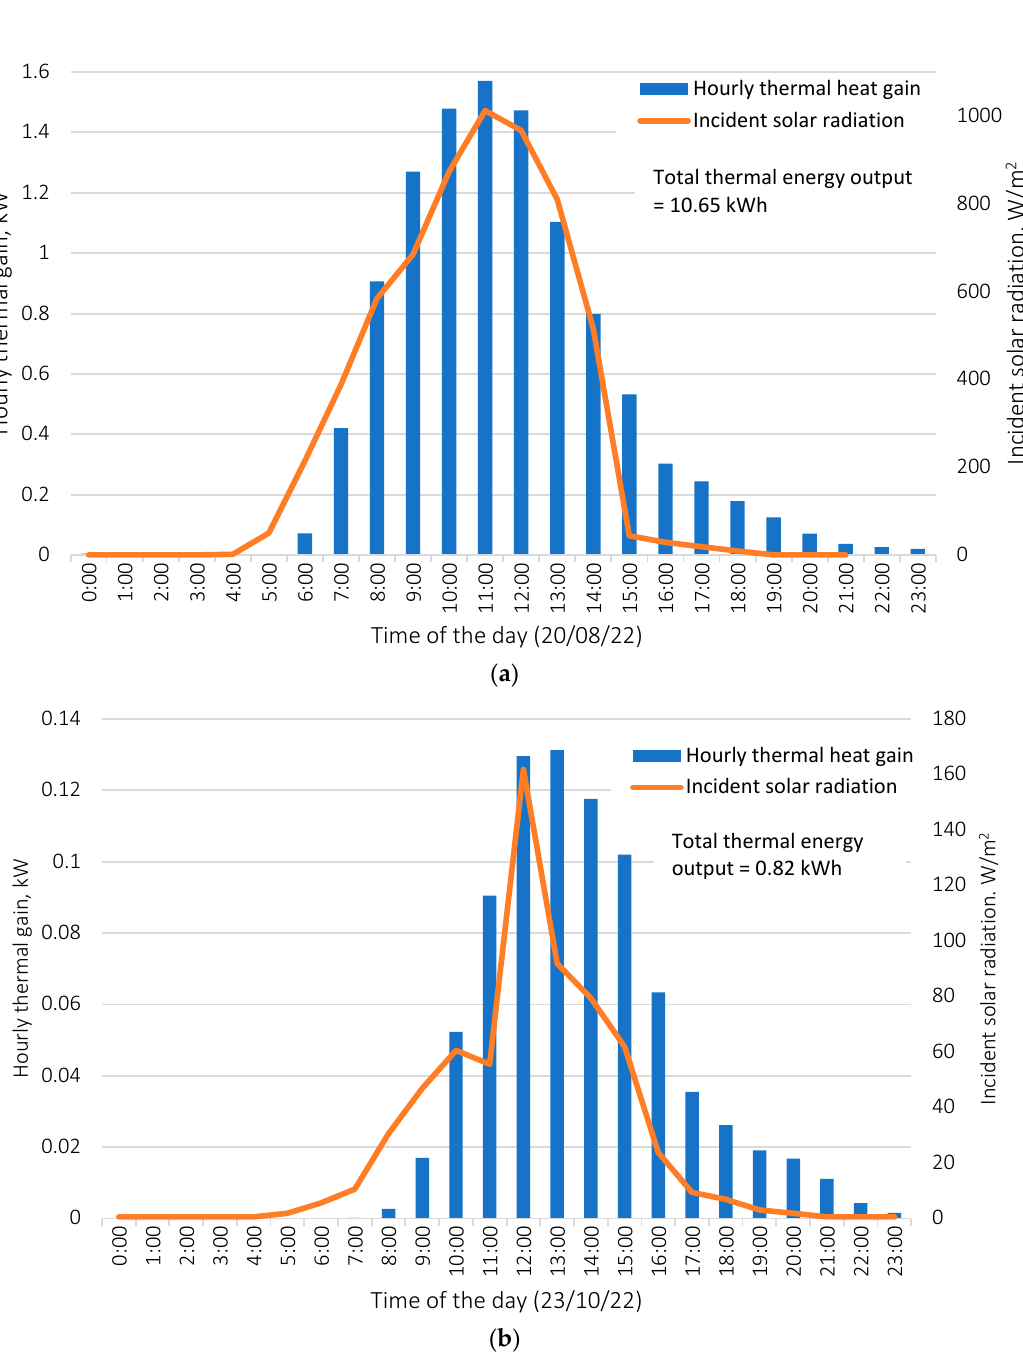
Table 3. Thermal energy yield (June—October 2022).